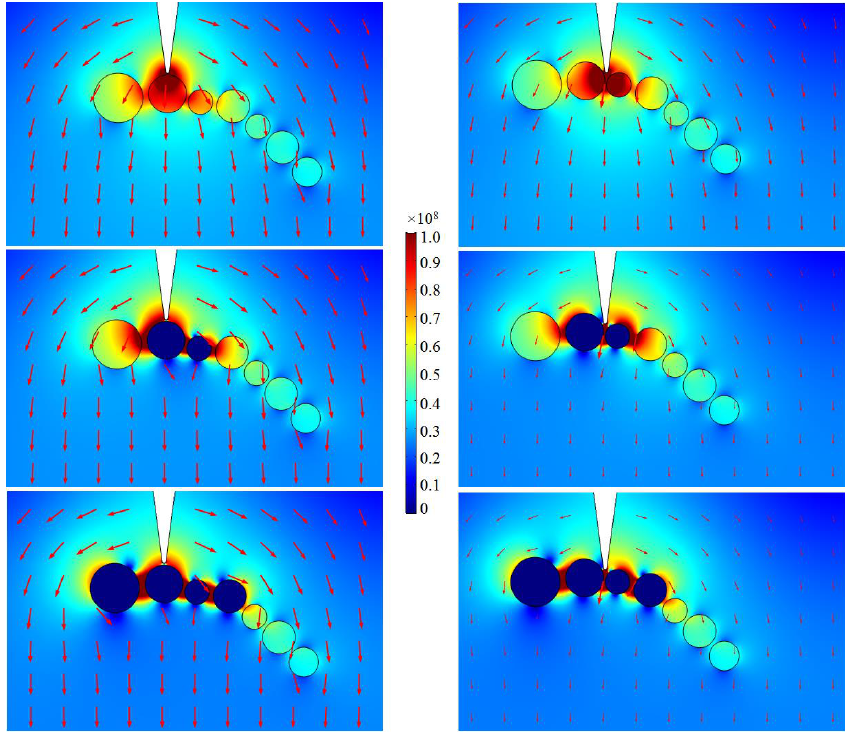
Figure 9. Electric field distributions when initiation tip (identical to tree front) approaching to the string of micropores (crack) in interface region of cable joint, locating on the micro-pore surface ( left panels ) or into the XLPE interval ( right panels ). The sequence of figure panels from top to end indicates the developing process of the carbonized breakdown channel through the string of micropores in electrical-tree propagation.